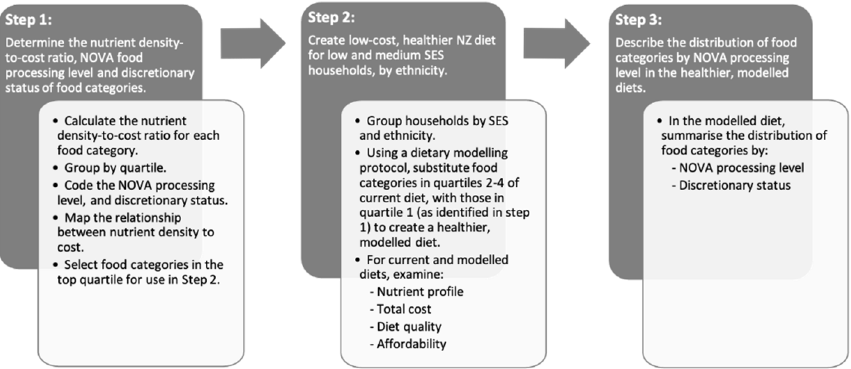
Figure 1. Summary of the major steps involved in the dietary modeling protocol to create nutrient dense, low-cost diets.